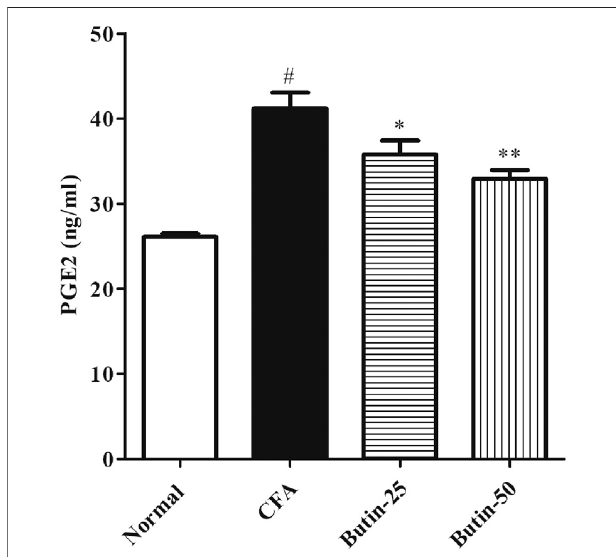
FIGURE5| EffectofbutinonPGE2levelsinCFA-treatedrats.Valuesare expressed in mean ± SEM ( n = 6). # p < 0.05 vs. normal control rats and ** p < 0.01 and *** p < 0.001 vs. CFA control rats. One-way ANOVA followed by Tukey ’ s post hoc test.